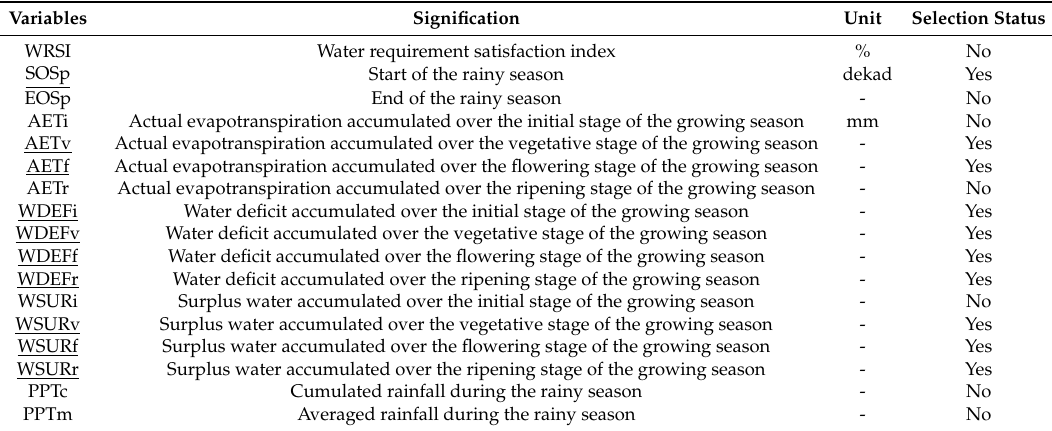
Table A1. Signification, unit and selection status after recursive feature elimination and variable inflation control of 17 agrometeorological variables provided by the GeoWRSI water balance model and used in the study. The 10 underlined variables correspond to those used for model development.